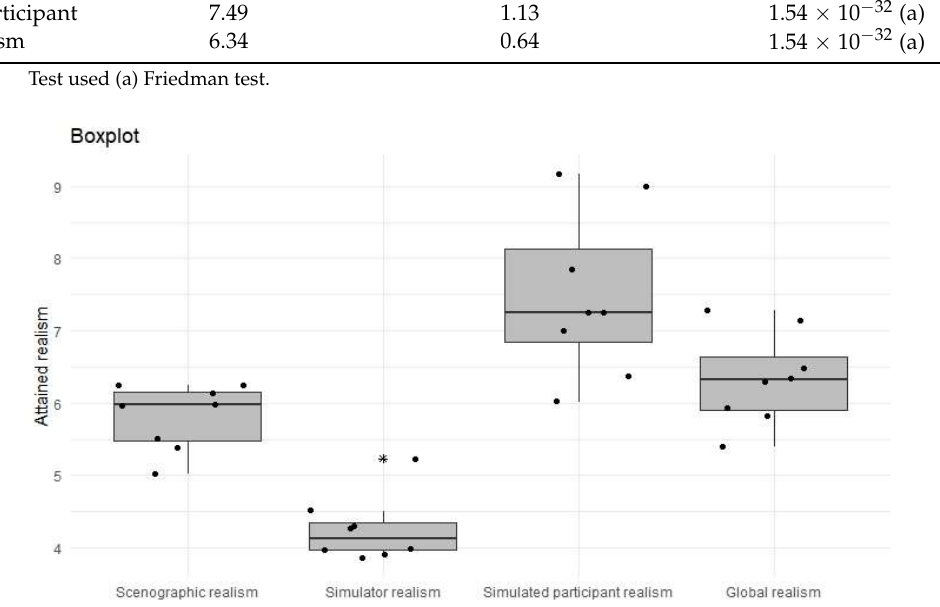
Table 3. Realism perceived by teachers.